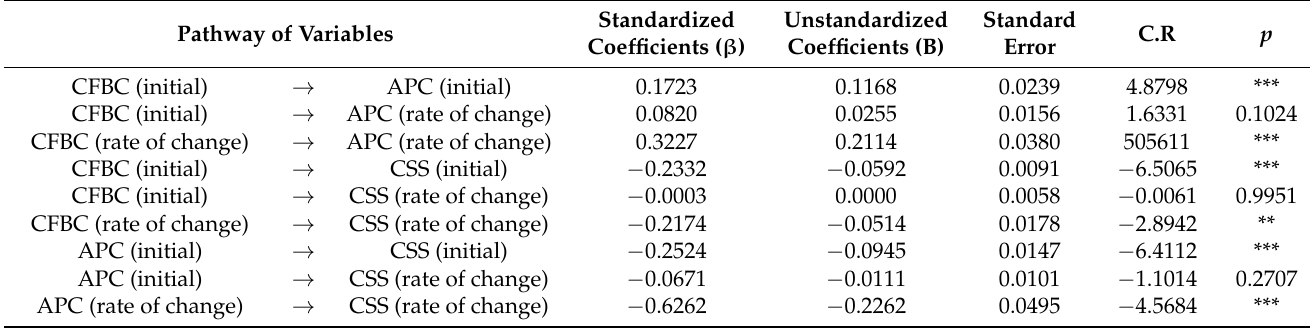
Table 6. Analysis of the path coefficients of the research model.